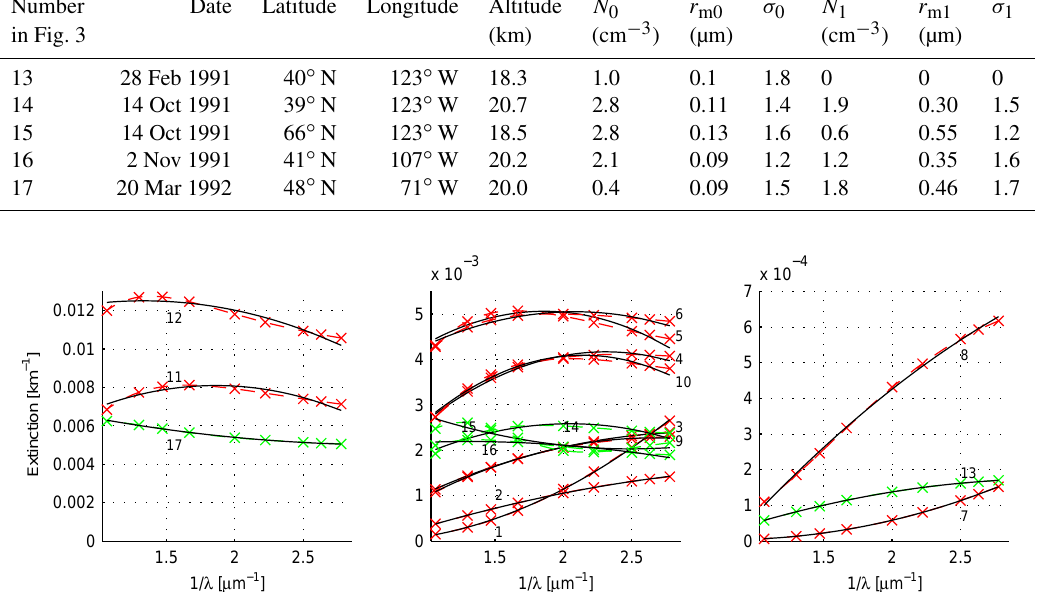
Figure 3. Measured and fitted stratospheric sulfate aerosol extinction spectra for different aerosol size distributions. The three panels each cover a different extinction magnitude range. Crosses with dashed lines represent values derived from a SAGE II–CLAES climatology (red) and in situ impactor measurements (green). Also shown is the fit with the second-order polynomial of inverse wavelength (black solid lines). The numbers on the plots correspond to the data in Tables 3 and 4.